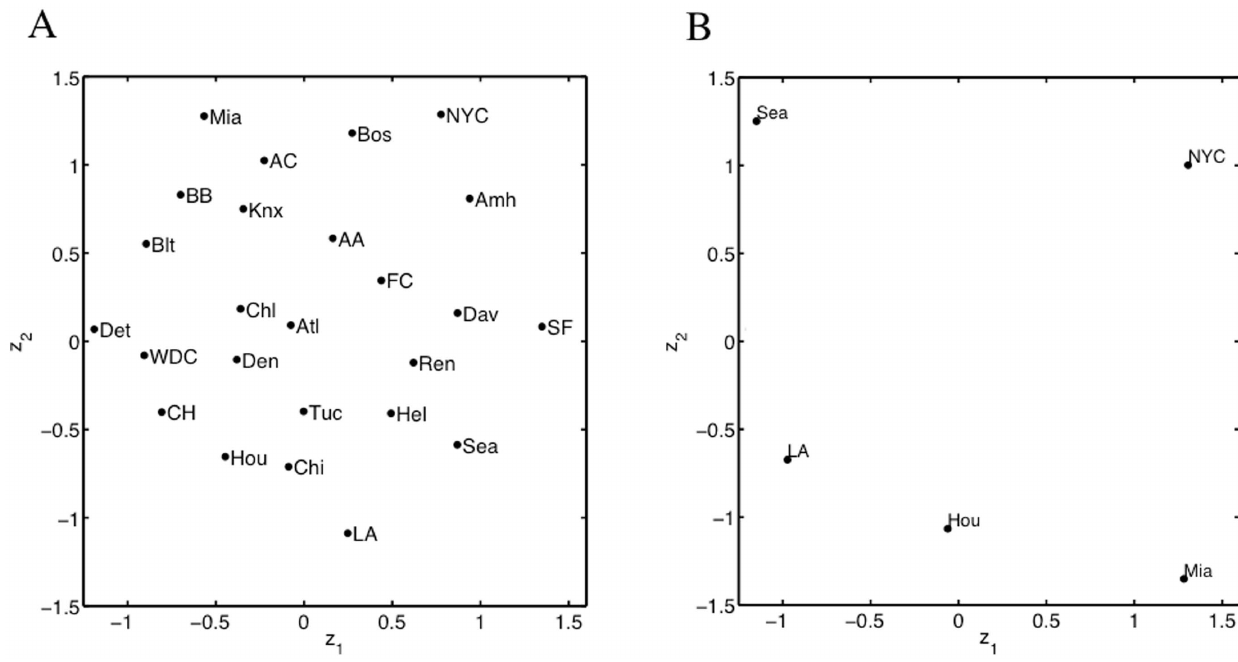
Figure 5. MDS view of the the city-data and an example of cognitive feedback. Figure A displays an Initial MDS view of the data set that describes 25 cities with 10 real variables and 20 noise variables. Figure B displays an example of cognitive feedback that arranges a set cities by relative geographic locations.